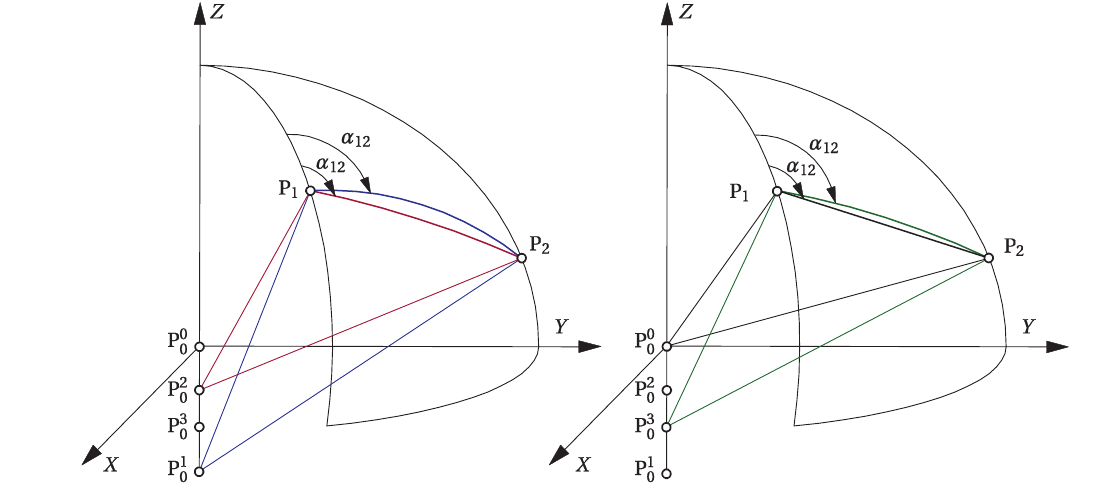
Figure 1. Schema of elliptical sections; on the left: the first (in blue) and second section (in red); on the right: the mean (in green) and central section (in